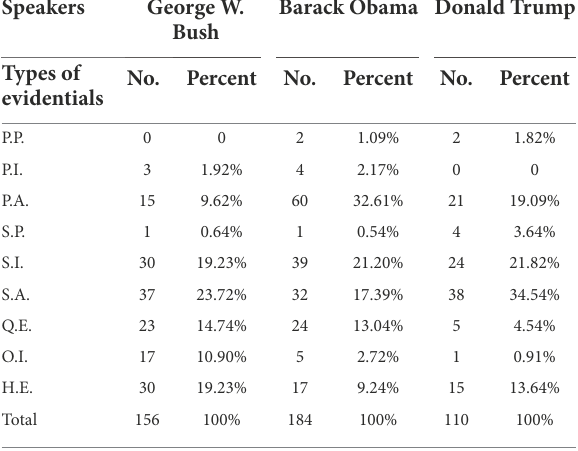
TABLE 3 The distribution of types of evidentials in three cases. Speakers George W. Bush Types of evidentials